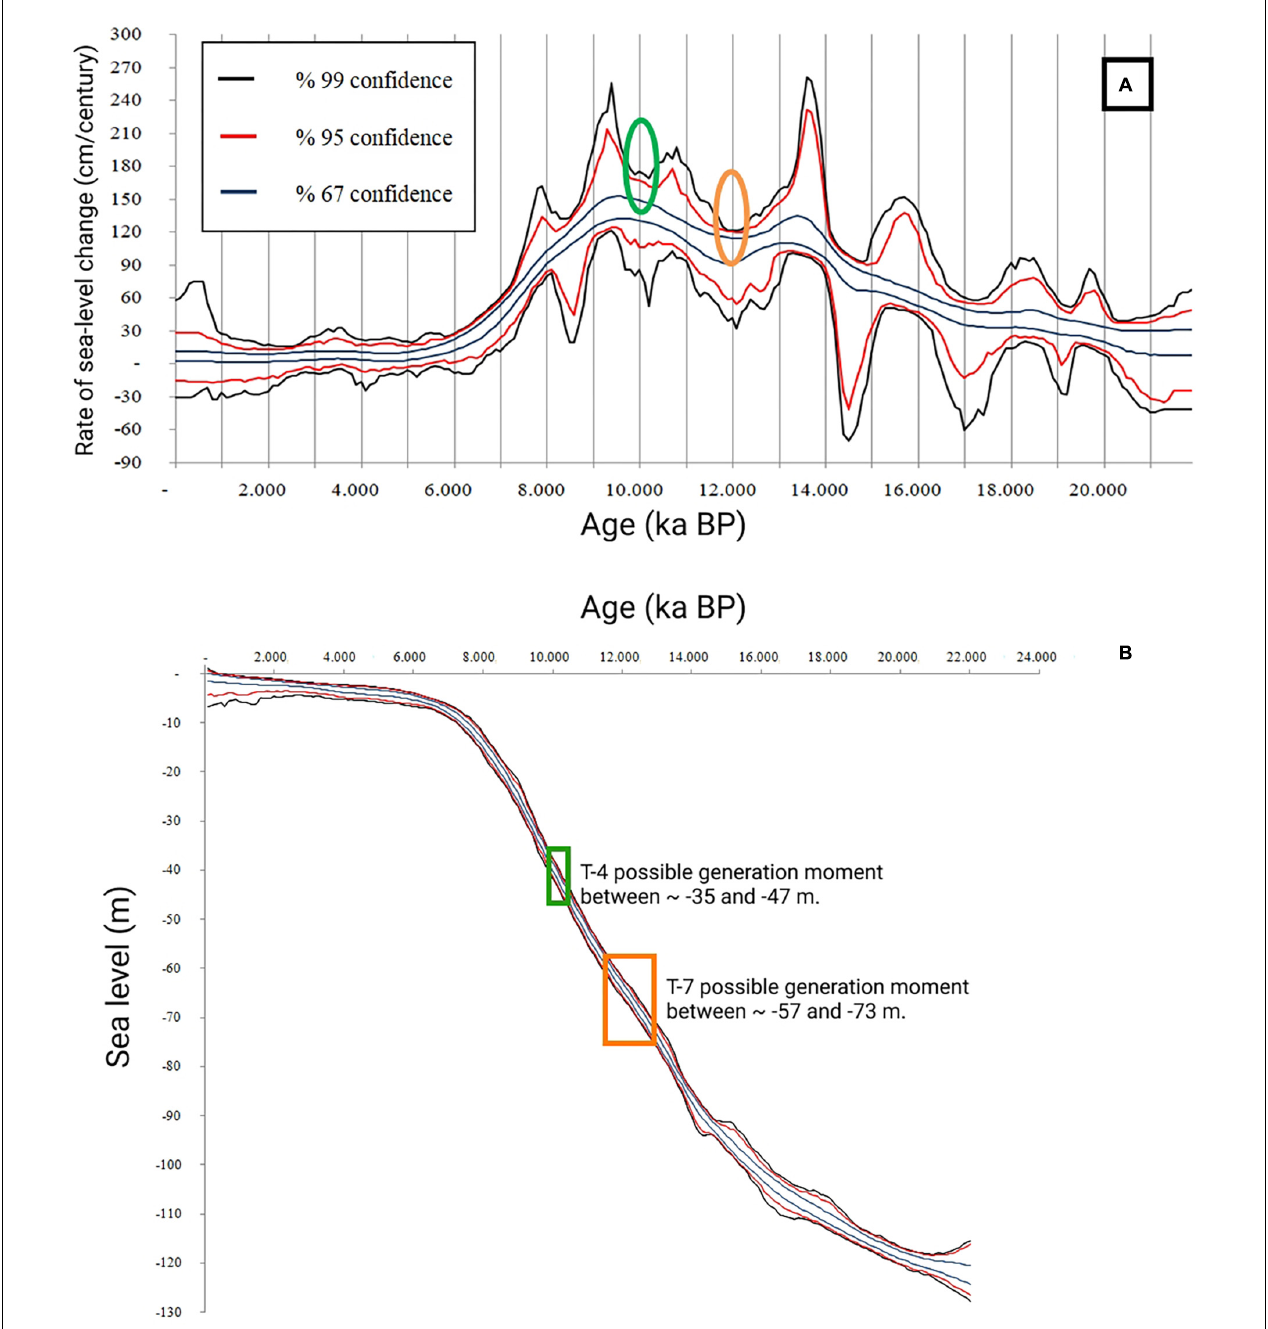
FIGURE 13 | T4 and T7 possible generation moment. (A) Stanford et al. (2011) rate of sea-level change, where T-4 and T-7 could have been generated. Green circle, the possible moment of T4 generation. Orange circle, the possible moment of T7 generation. (B) Extrapolated depths for the previously mentioned periods, in the sea level curve of Stanford et al.